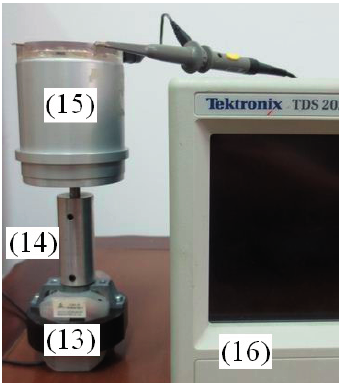
Figure 18. Connection diagram of a single-phase asynchronous motor angular acceleration testing.